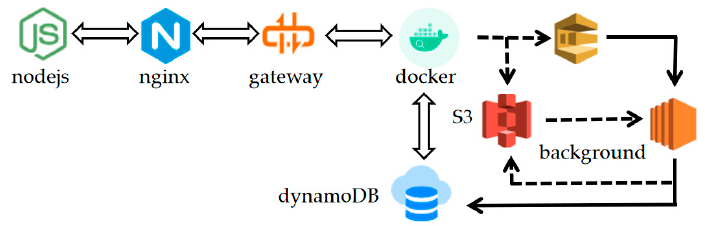
Figure 2. System Architecture.